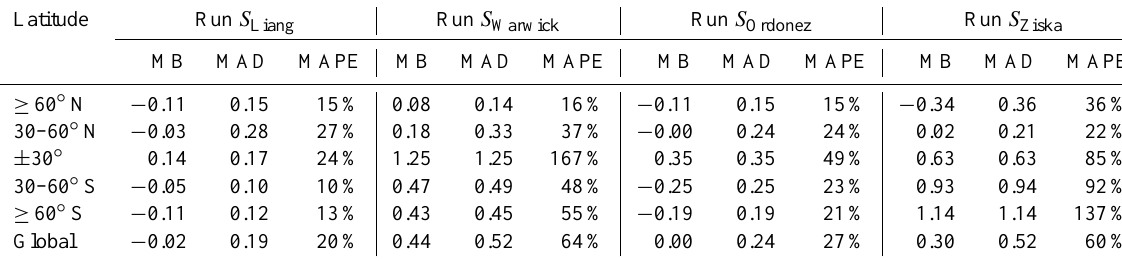
Table 4. As Table 3 but for CH 2 Br 2 .